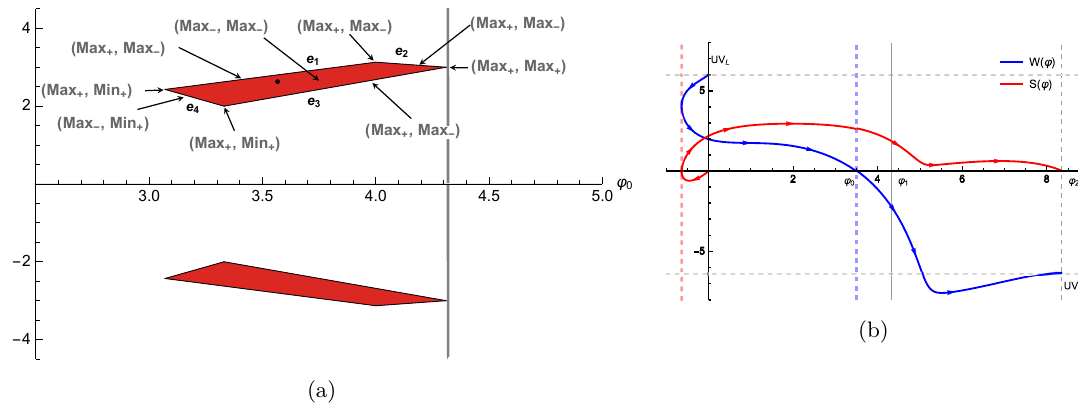
solutions. The black dot represents 1 , 1 are between the UV boundary and UV . L R 1 , 1 0 in figure (a) 0 < but at W < 0 . L